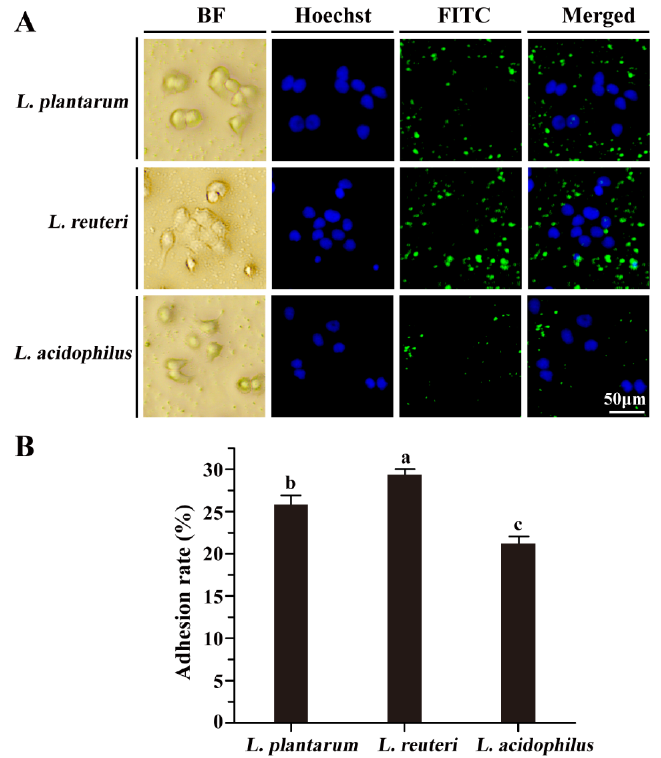
Figure 2. Adhesion of Lactobacillus on Caco-2 cells after 2 h of incubation at 37 °C in a 5% CO 2 atmosphere. ( A ) Lactobacillus was stained with FITC (green fluorescence), and the nuclei of Caco-2 cells were stained with Hoechst 33342. ( B ) The adhesion rate was evaluated by the fluorescence intensity of the Lactobacillus strains. Values with the different letters are significantly different, while the same letters indicate no significant difference among the tested strains (Duncan’s test, p < 0.05).